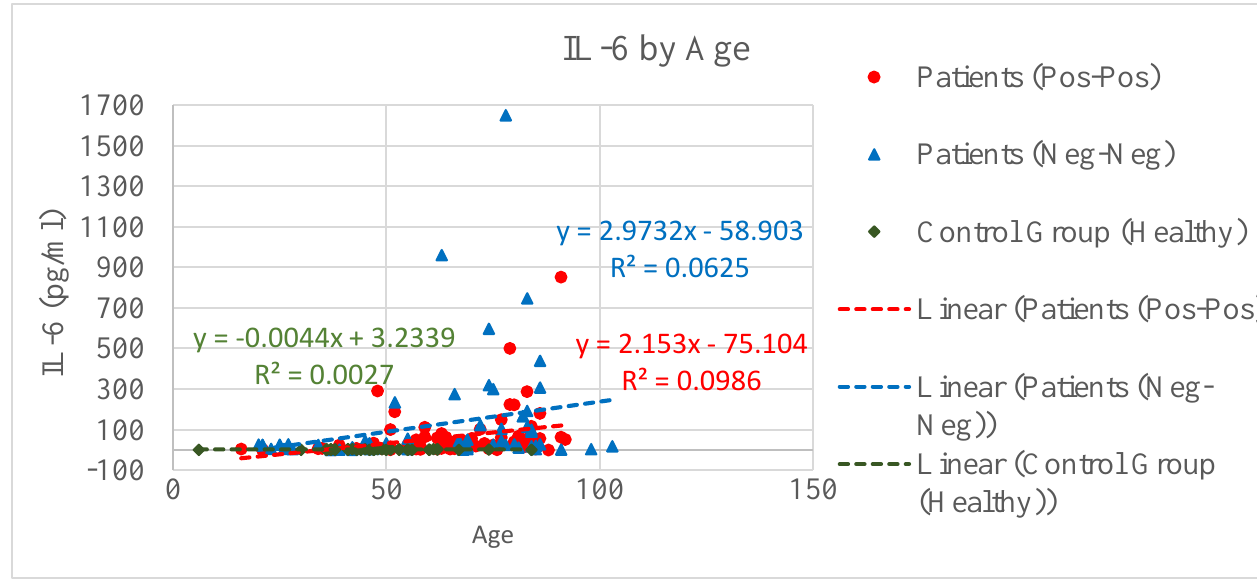
Figure 2. Scatter charts and regression lines for IL-6 by age for COVID-positive (PP), COVID-free patients (NNp), and the healthy group (NNh). It is a truncated IL-6 axis to show more details in the medium area of IL-6 concentration. IL-6 growth is seen in PP and NNp event consistent with an ongoing inflammatory process associated with age; the older the patient is, the higher the IL-6 is.